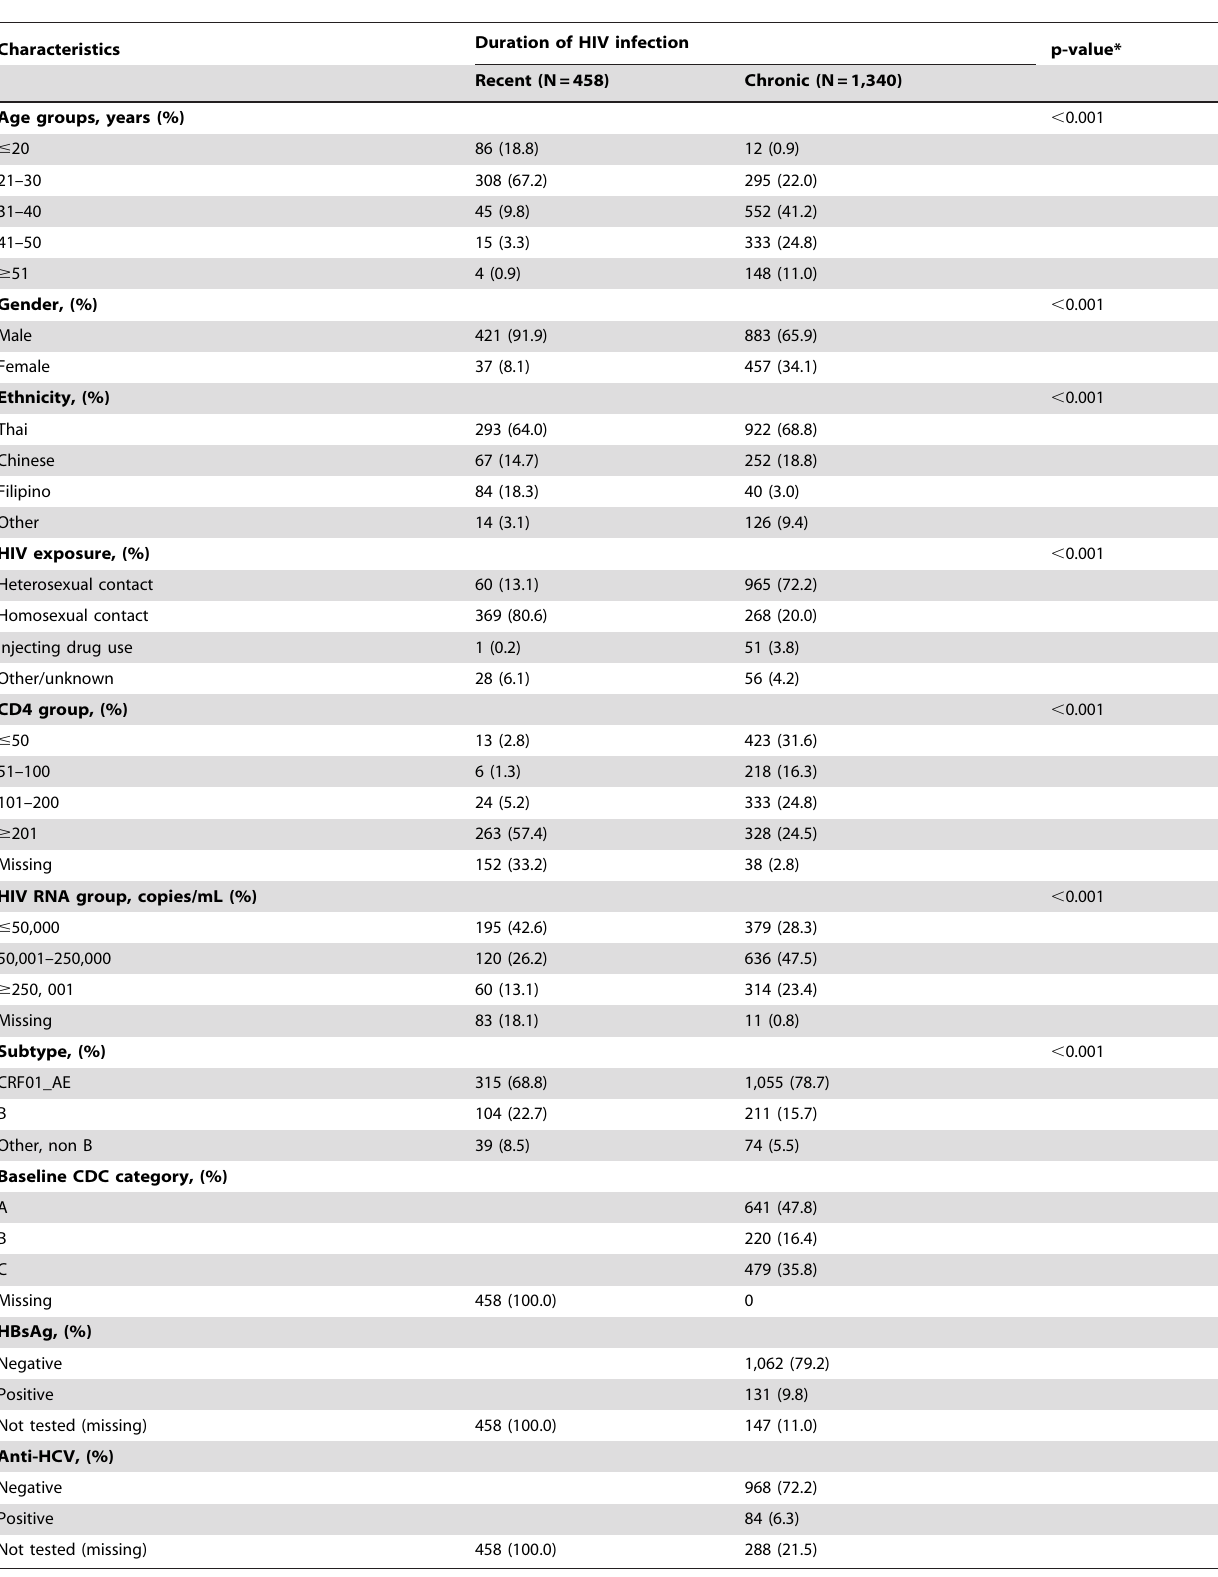
Table 1. Baseline characteristics of 1,798 HIV-infected antiretroviral therapy-naı¨ve patients stratified by duration of HIV infection.